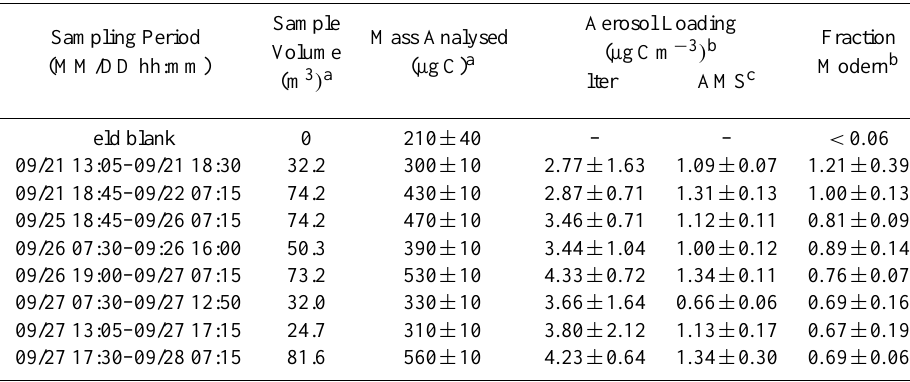
Table 1. Total carbon mass analysed (mgC), aerosol loading (PM 2 . 5 ; µgCm − 3 ) and fraction of modern carbon determined from the radiogenic ( 14 C) carbon results. For comparison the aerosol loading (PM 1 ; µgCm − 3 ) from the AMS averaged onto the same timescale as the filter samples are also